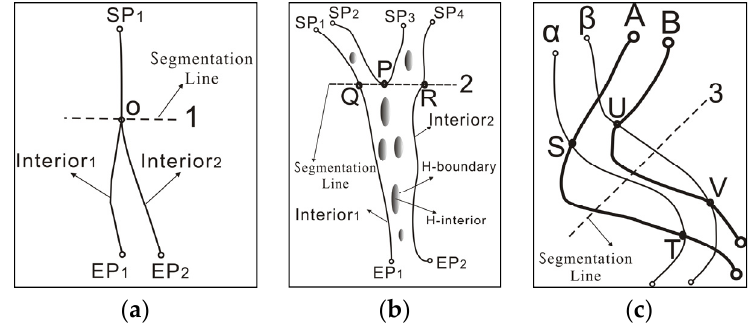
Figure 10. Segmentation rules for river planforms. ( a ) Segmentation Rule 1 from SSLMs to DSLMs; ( b ) Segmentation Rule 2 from double line to three or more lines; ( c ) Segmentation Rule 3 based on the two neighbour intersections.